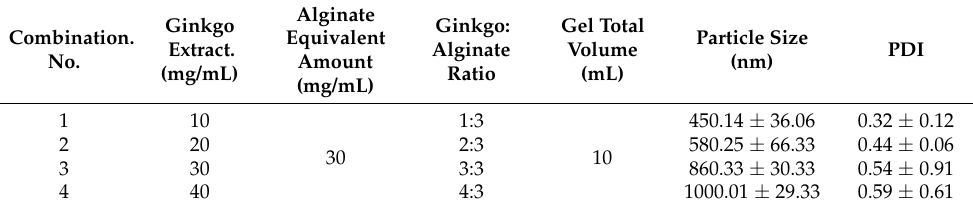
Table 1. Illustration of the different formulation components for optimization. Combination.